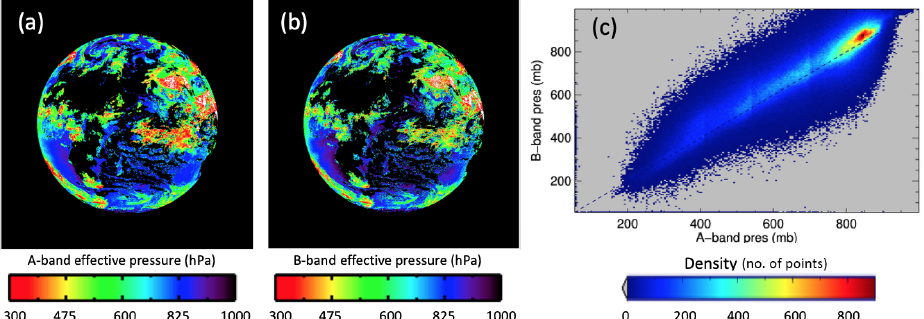
Figure 4. Sample EPIC L2 cloud effective pressure (CEP) products. Same granule as Fig. 3, but for (a) O 2 A-band CEP, (b) O 2 B-band CEP, and (c) scatterplot for A- vs. B-band